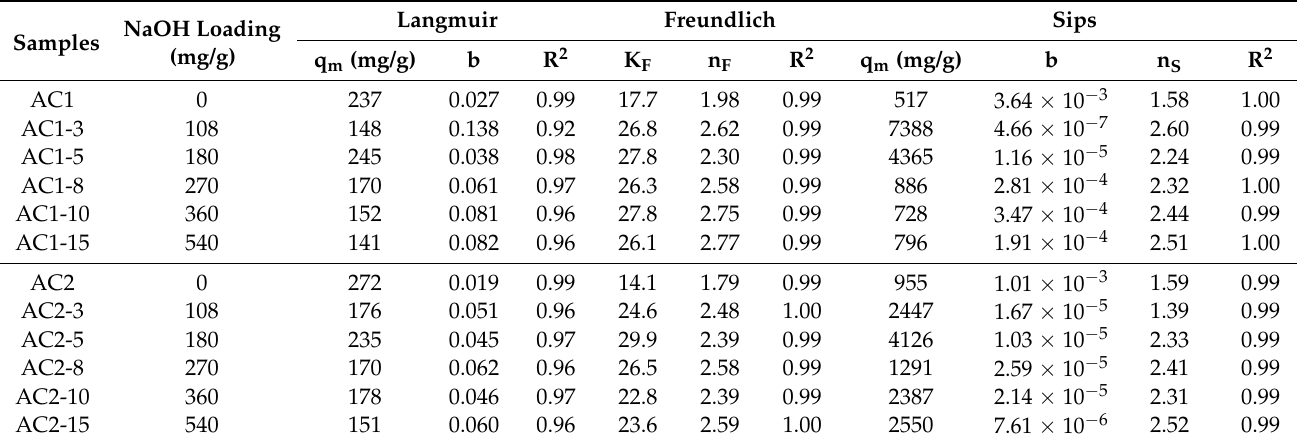
Table 5. Fitted parameters of isotherm equations for CO 2 adsorption at 273 K by the original and NaOH impregnated activated